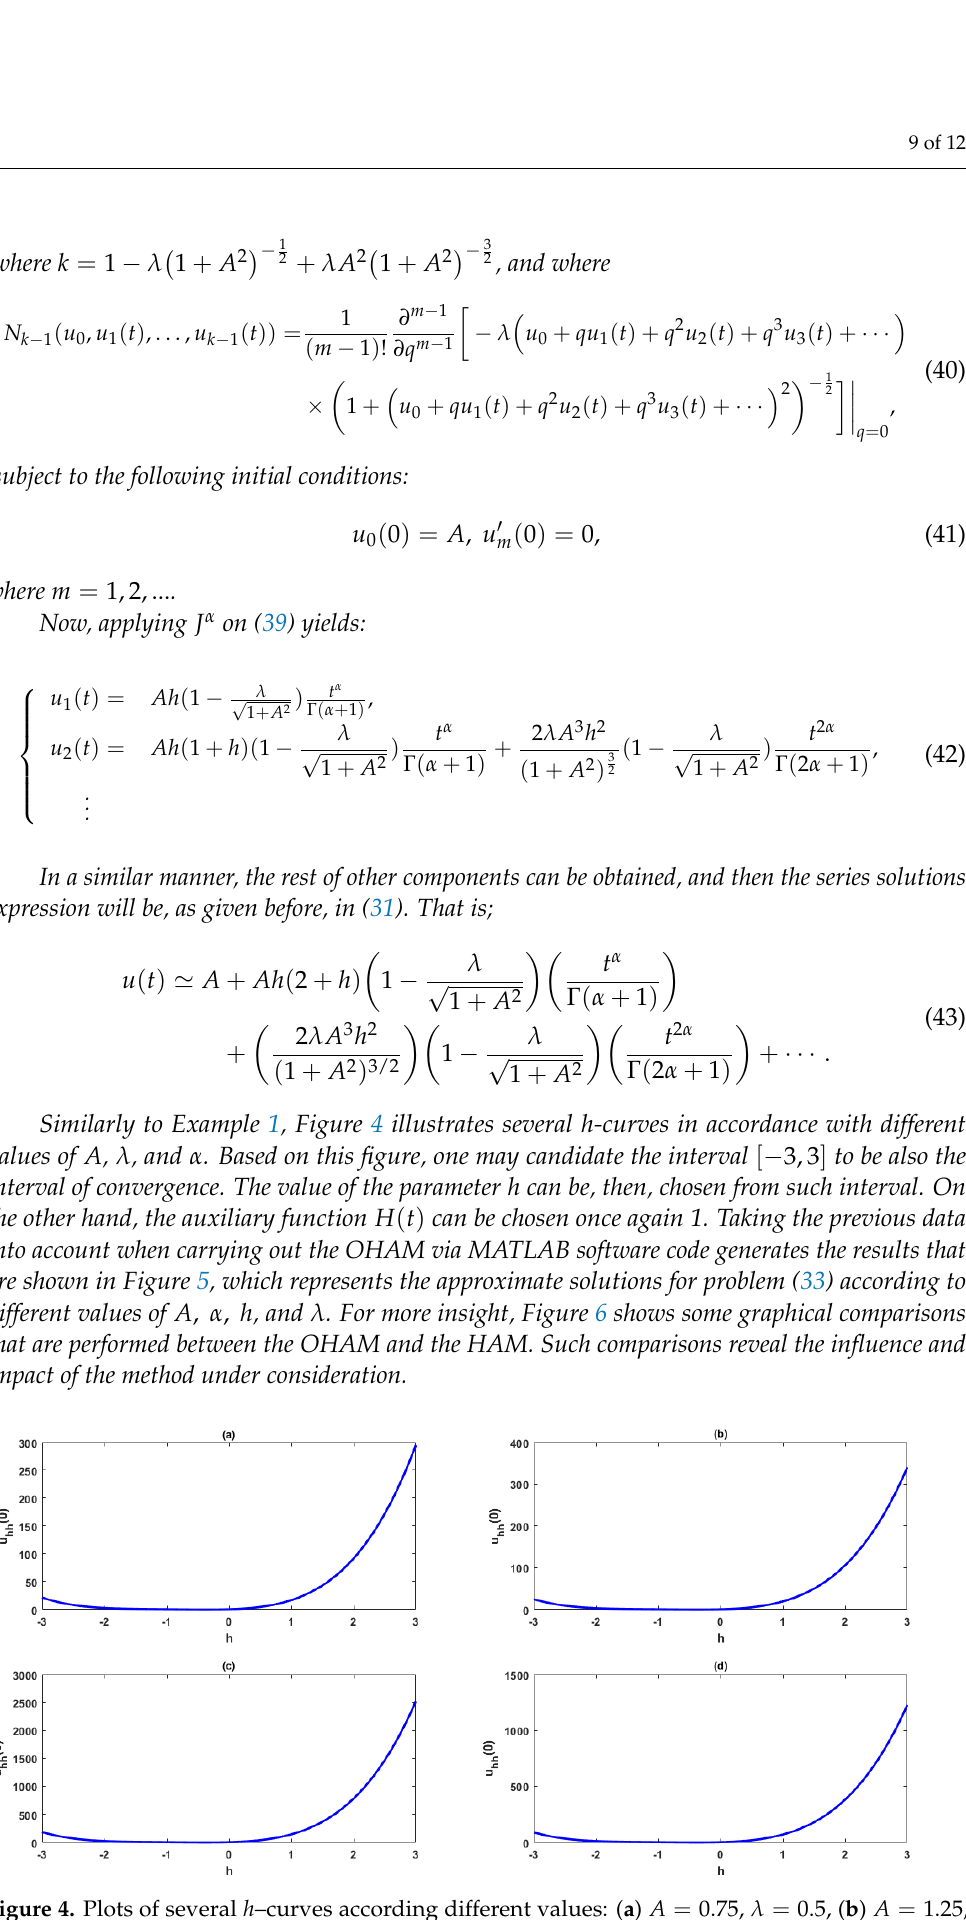
Figure 4. Plots of several h –curves according different values: ( a ) A = 0.75, λ = 0.5, ( b ) A = 1.25, λ = 0.5, ( c ) A = 2, λ = 0.9, and ( d ) A = 1.5, λ = 0.95